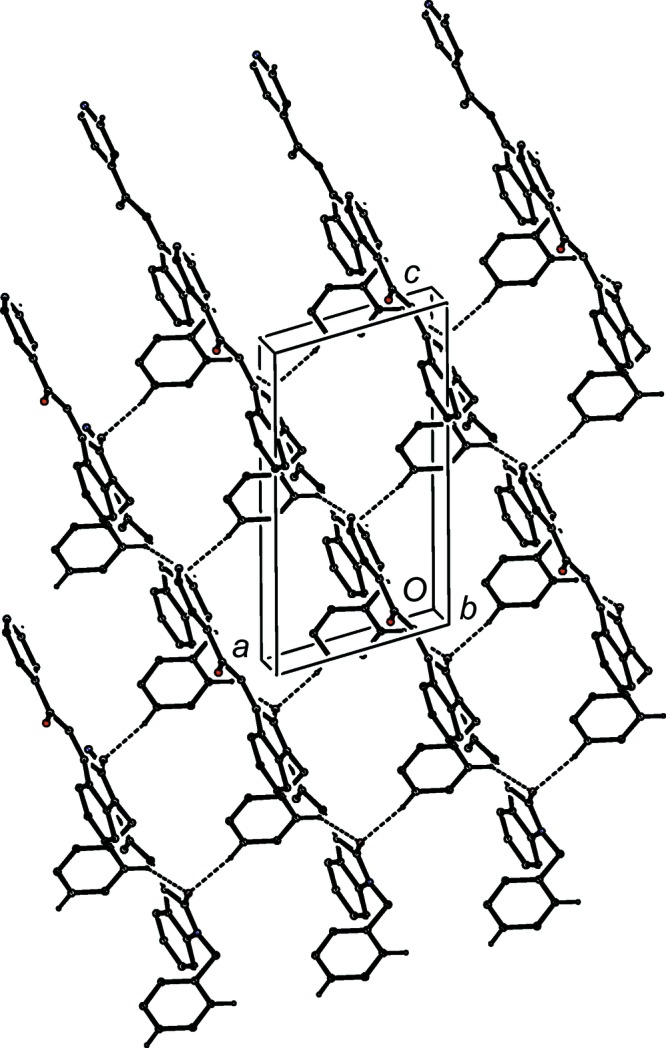
Part of the crystal structure of com­pound (IIe), showing the formation of a sheet built from three C—H⋯O hydrogen bonds and lying parallel to (010). Hydrogen bonds are drawn as dashed lines and, for the sake of clarity, H atoms not involved in the motifs shown have been omitted.